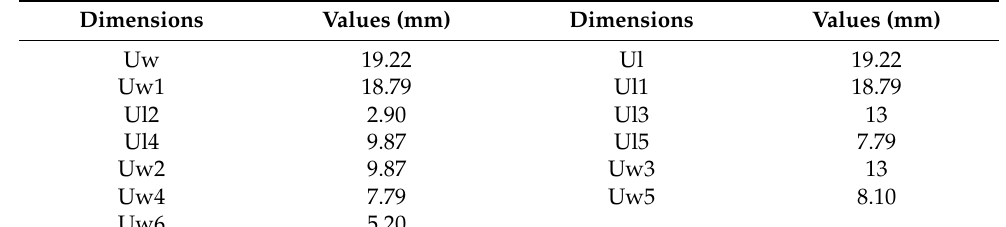
Table 3. Dimensions of the unit cell.